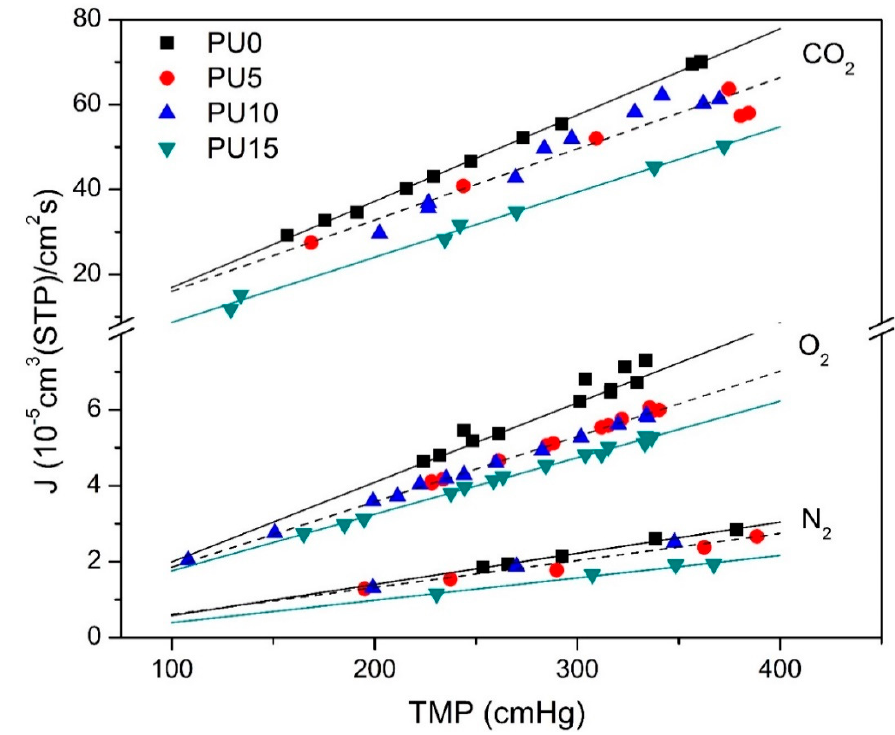
Figure 6. N 2 , O 2 , and CO 2 volumetric fluxes ( J ) vs. the transmembrane pressure (TMP) for PU0 (black square), PU5 (red circle), PU10 (blue triangle), and PU15 (green inverted triangle) membranes; lines (straight-line fit using the method of least squares) PU0 in solid black, PU15 in solid green and a joint fit of PU5 and PU10 in dashed black.